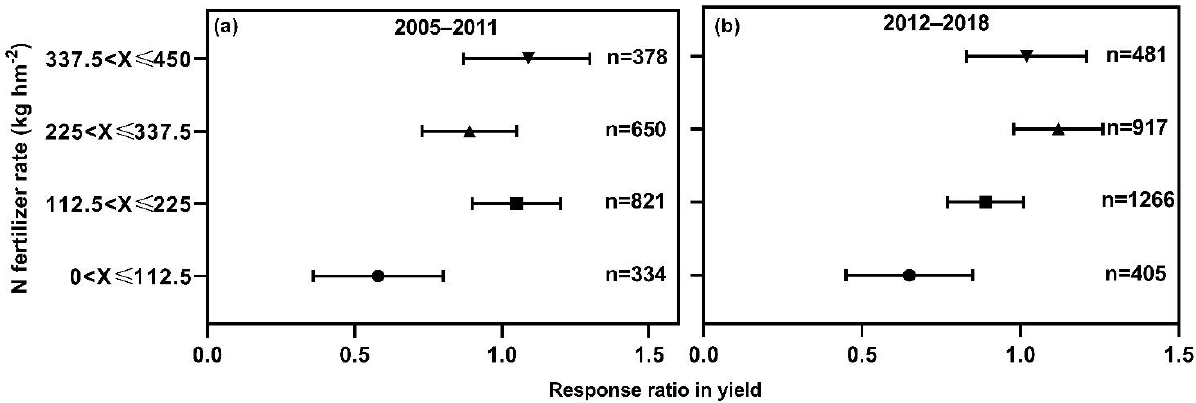
Figure 4. The effects of N fertilization levels on maize yield in different periods. ( a ) 2005 – 2011, ( b ) 2012 – 2018. The error lines indicate the 95th percentile bootstrap confidence intervals, whereas n values indicate the corresponding number of observations (total number of control and treatment values). Yield with N fertilization is a treatment value, whereas yield without N fertilization is a control value.